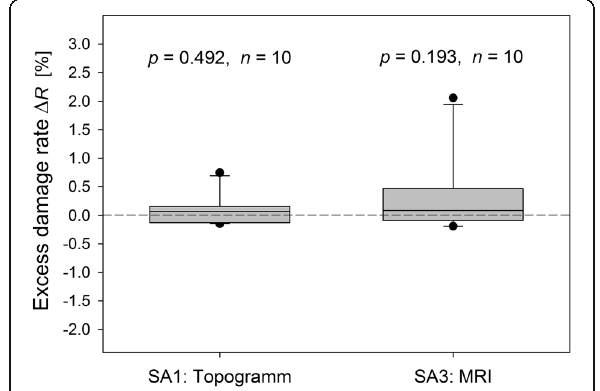
Fig. 6 Excess damage rates determined for lymphocytes isolated from blood samples taken before (SP1/IT60) and after (SP2/IT60) the acquisition of the topogram in SA1 and the MRI sequence in SA3 (Wilcoxon test). Scaling is identical with Figs. 7 and 8